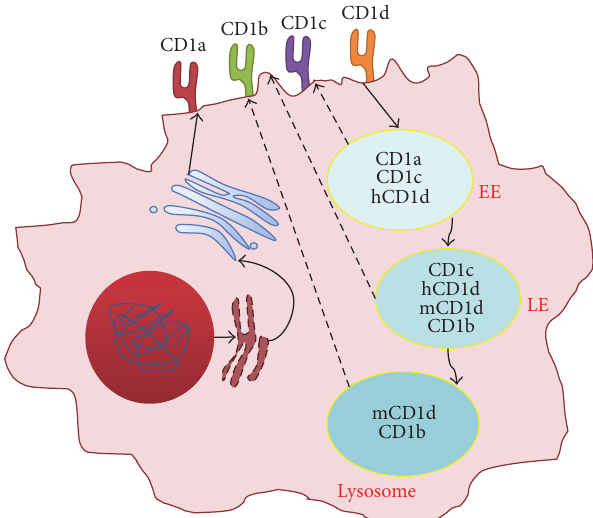
Figure 2: The cellular trafficking of CD1 molecules. After synthesis, CD1 molecules associate with 𝛽 2-microglobulin in the endoplasmic reticulum. Then, they traffic to the trans-Golgi network, where they are glycosylated and follow to the plasma membrane (solid arrows). There, CD1 molecules are internalized by the endocytic pathway, where most of the loading occurs. The different CD1 isoforms localize in different endocytic compartments. The loaded CD1 molecules then traffic to the plasma membrane, where they activate T cells (dashed arrows). EE: early endosome; LE: late endosome; hCD1d: human CD1d; mCD1d: mouse